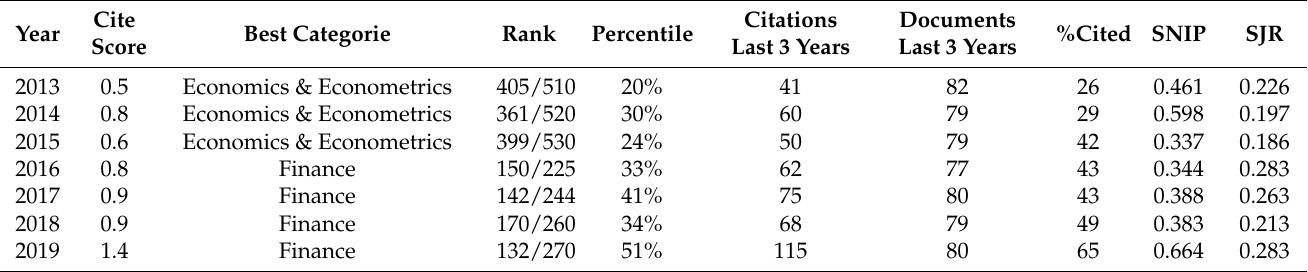
Table 2. CiteScore metrics for SJFA.